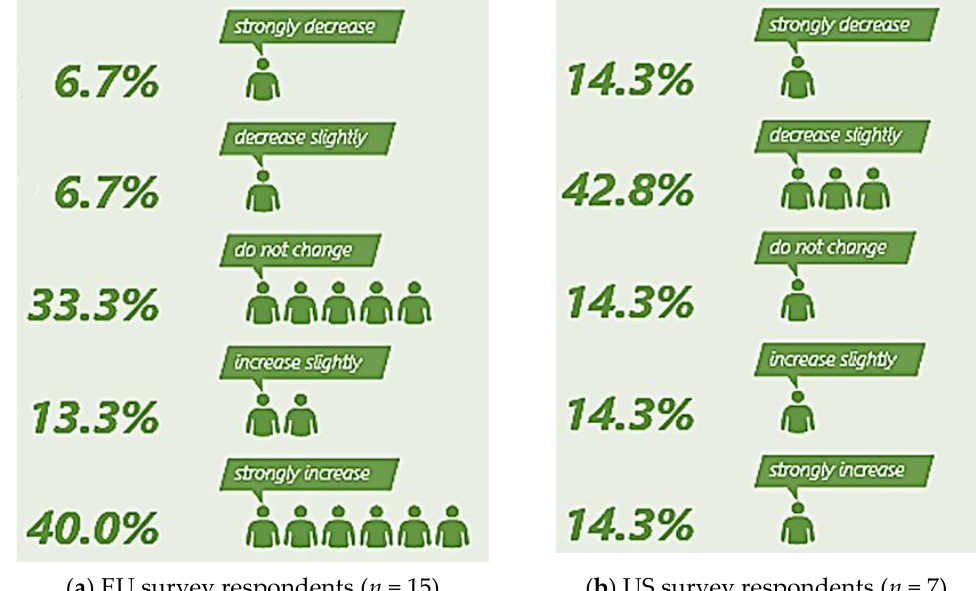
Figure 4. For companies in the EU ( a ) and the US ( b ), the expected shifts in the coordination process of the customer–supplier relationship along the FSC regarding the TTIP; absolute and percentage values. Source: own calculation.